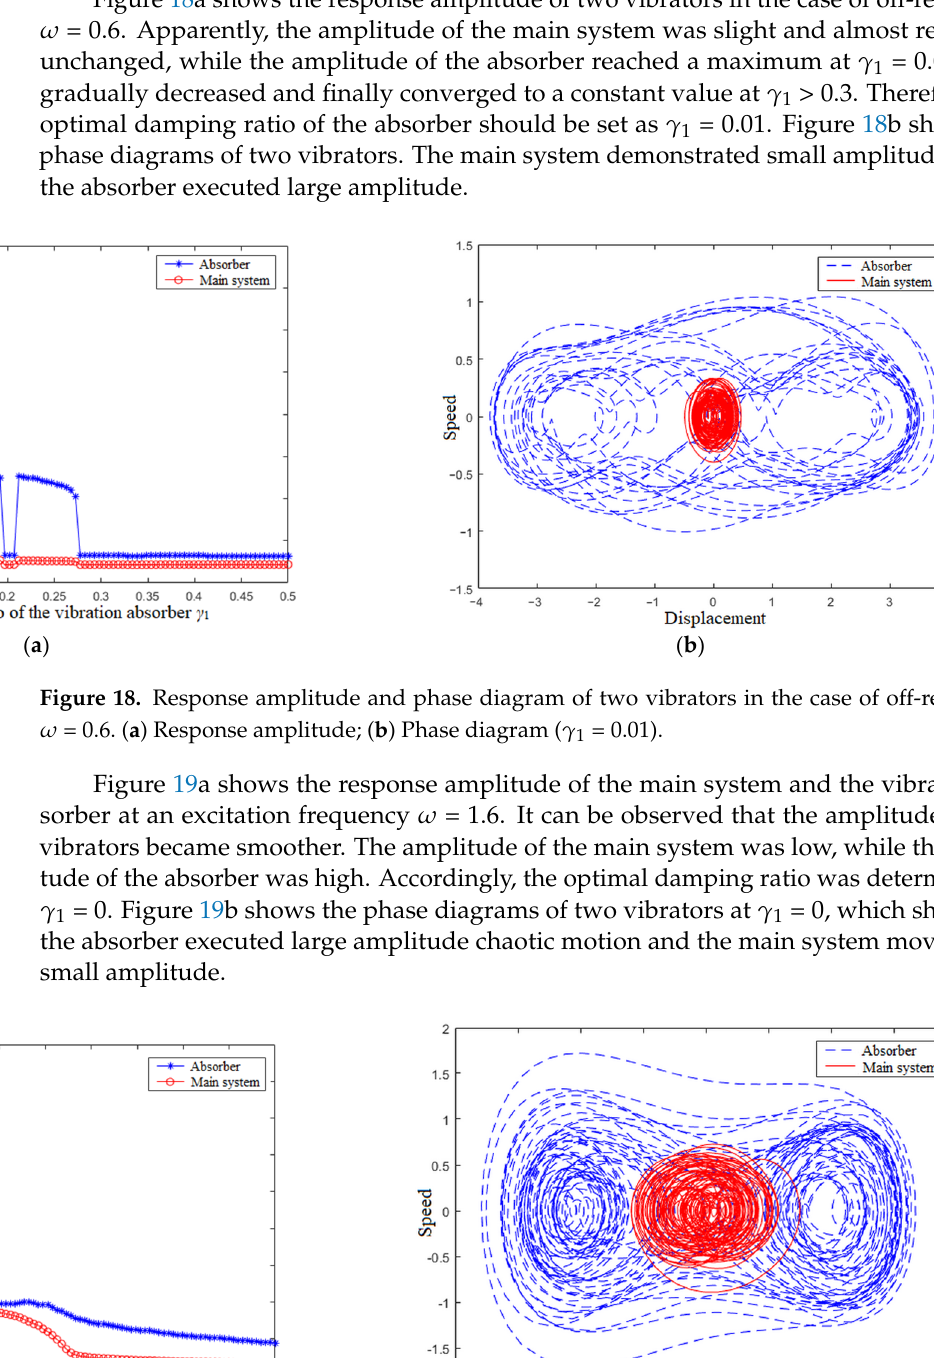
Figure 17. Response amplitude of two vibrators and phase diagram of main system in the case of resonance ω = 1.0. ( a ) Response amplitude; ( b ) Phase diagram ( γ 1 = 0.05).